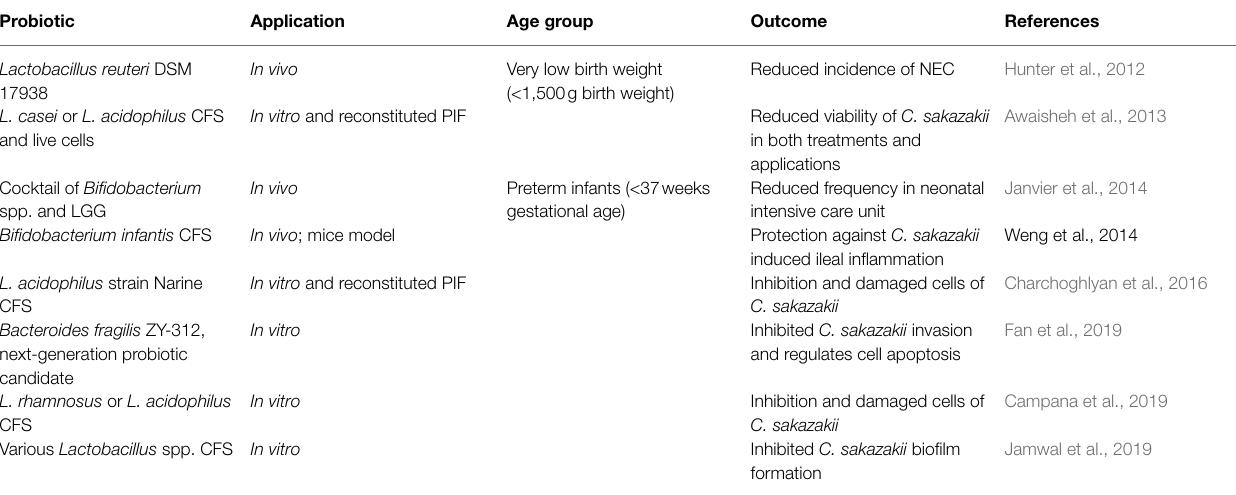
TABLE 5 | Summary of probiotic strains reported to decrease C. sakazakii